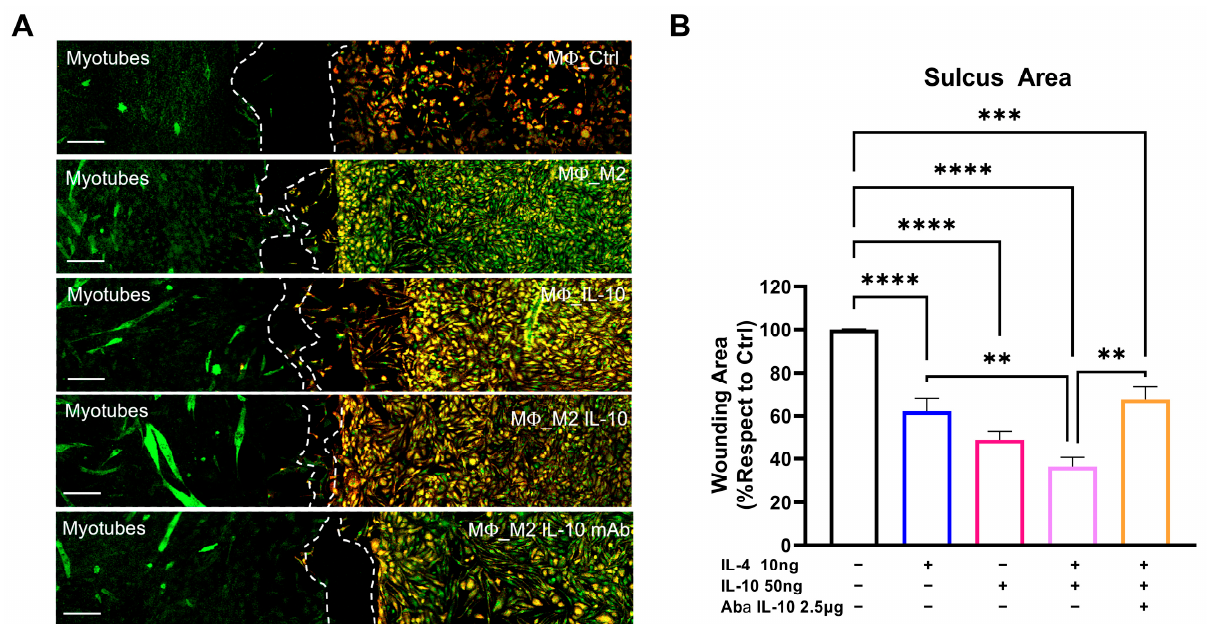
Figure 5. IL-10 in vitro administration enhances the macrophage–satellite cell interplay. ( A ) Repre- sentative confocal images showing the immunostaining for primary C57-SOD1G93A-derived SCs (MF20-MyHC, green) and M Φ s (CD11b, yellow). M Φ s were selectively polarised to the M2 pheno- type and treated with 50 ng/mL IL-10. Dotted lines spotlight the area of sulcus at 48 h following the removal of the insert. Scale bar = 100 µ m. ( B ) The migration rate was calculated using the wound- healing assay. The data are reported as (mean ± SEM) from at least six independent experiments. ** p < 0.01, *** p <0.001, **** p <0.0001 by one-way ANOVA with Tukey’s post-analysis.